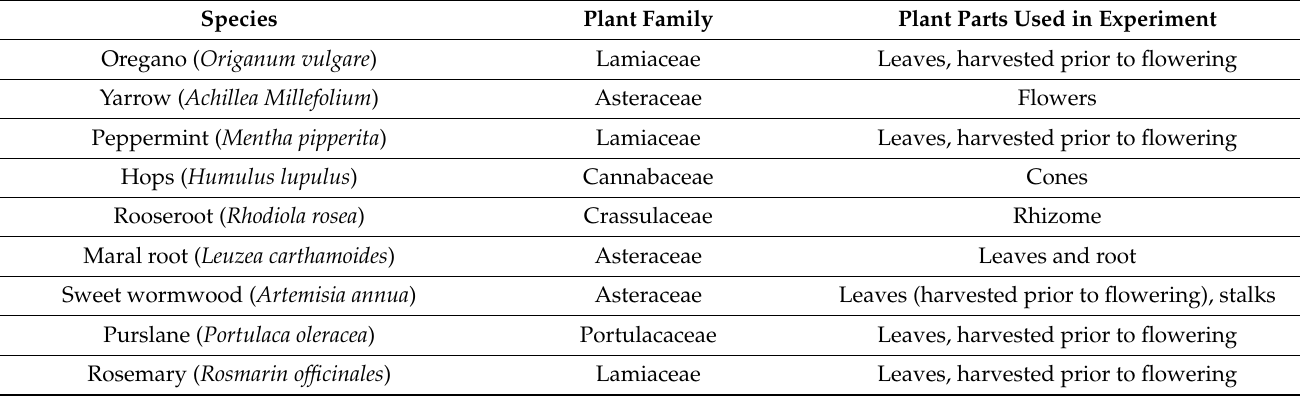
Table 6. Overview of plant species and plant parts used for solvent extraction.